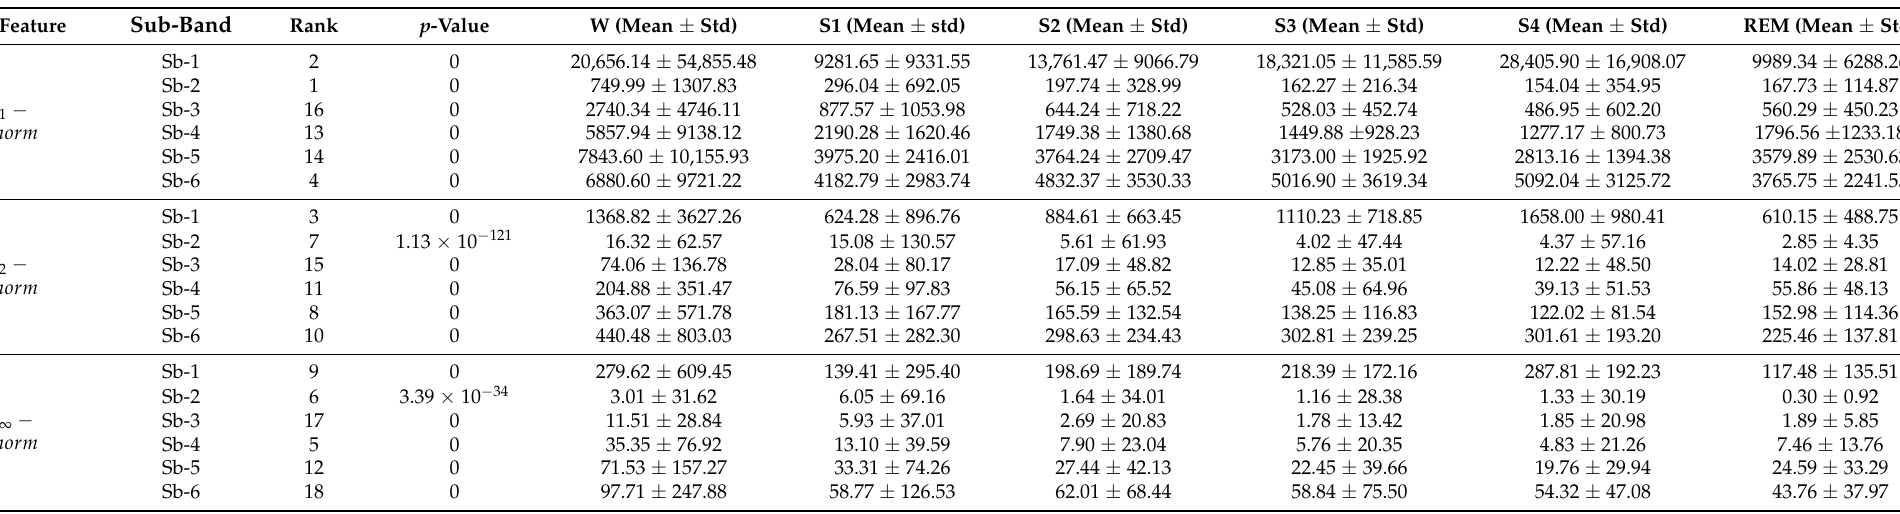
Table 5. Statistical analysis using ANOVA for F4-C4